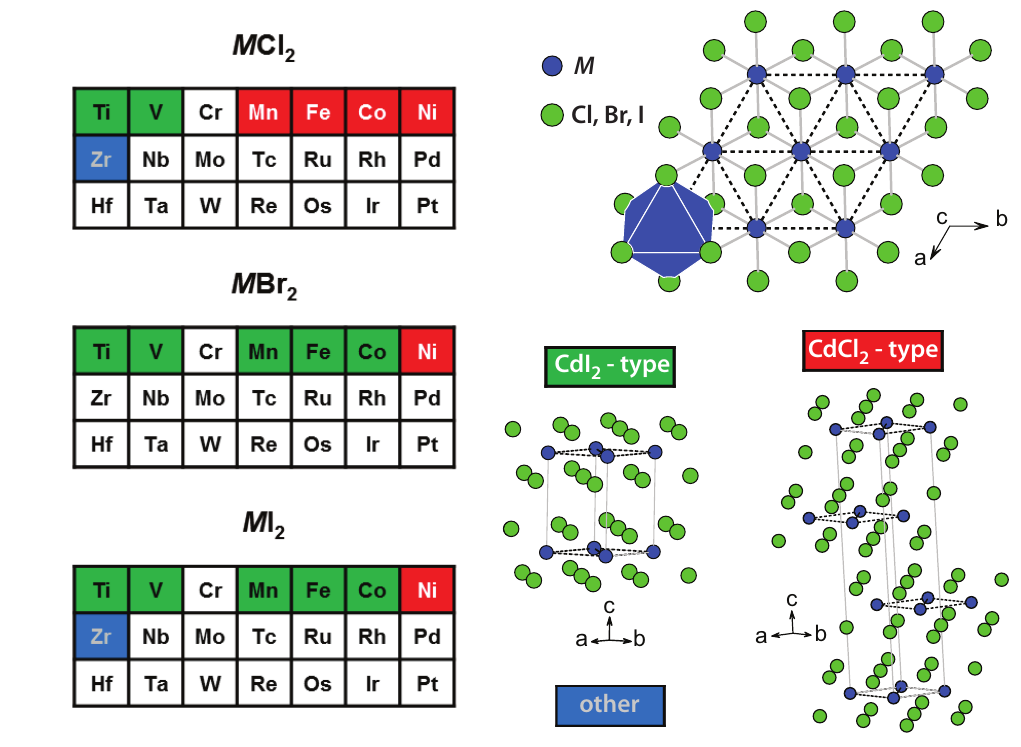
Figure 1. A section of the periodic table showing the transition metals for which layered MX 2 compounds listed in Table 1 form. The metals are highlighted with colors that correspond to the structure types shown on the lower right. A plan view of a single layer common to both the CdI 2 and CdCl 2 structure types is shown on the upper